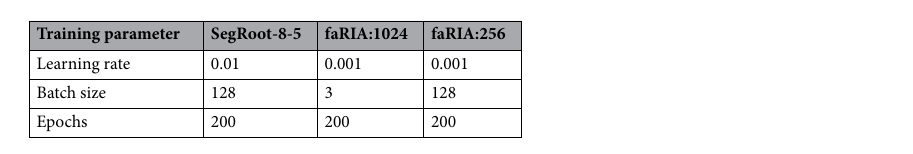
Table 4. Training parameters of SegRoot, faRIA:1024 and faRIA:256 over 200 epochs.